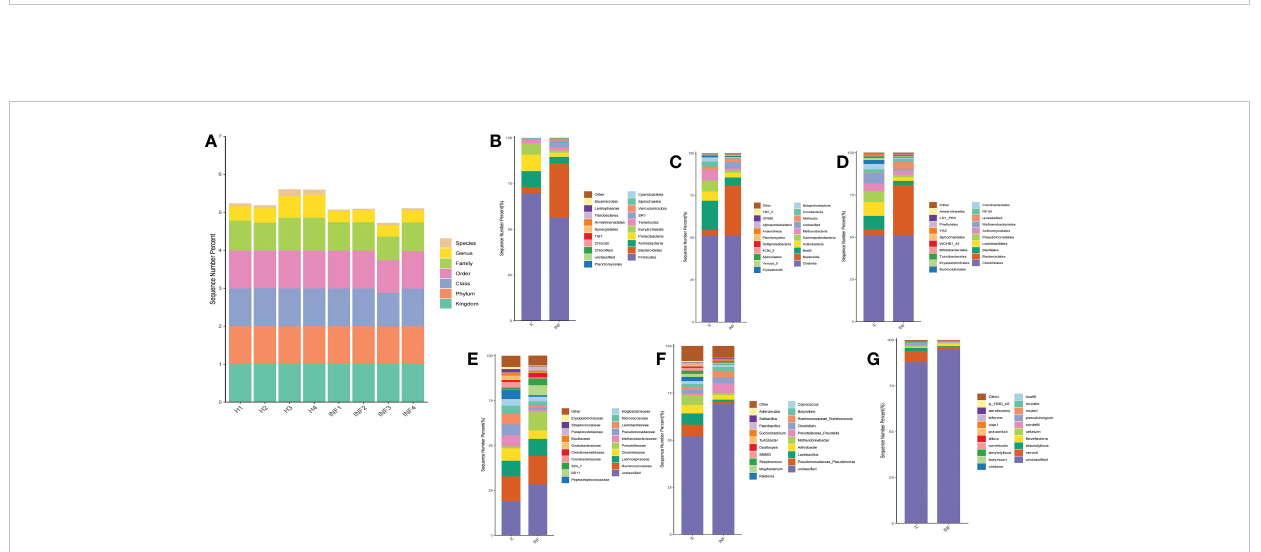
FIGURE 2 Statistical analysis of yak microbiota in different taxa. (A) Sequence percentages in different taxa, (B) Phylum, (C) Class, (D) Order, (E) Family, (F) Genus, (G)